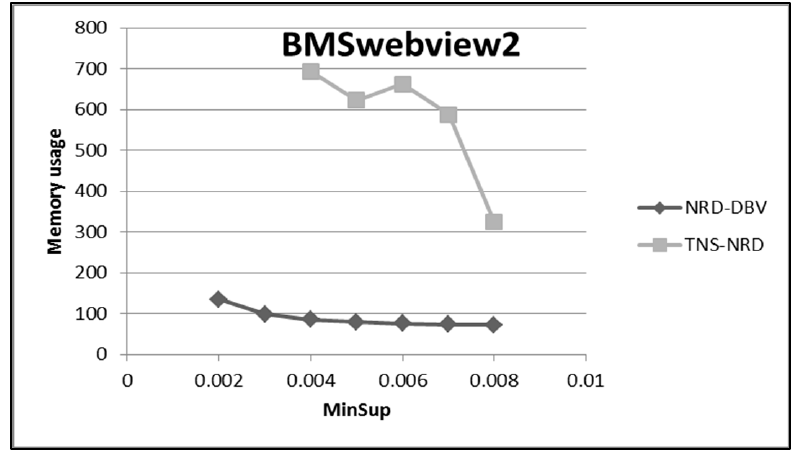
Figure 27. Comparison of memory usage for the TNS with the NRD-DBV algorithm for (BMS web-